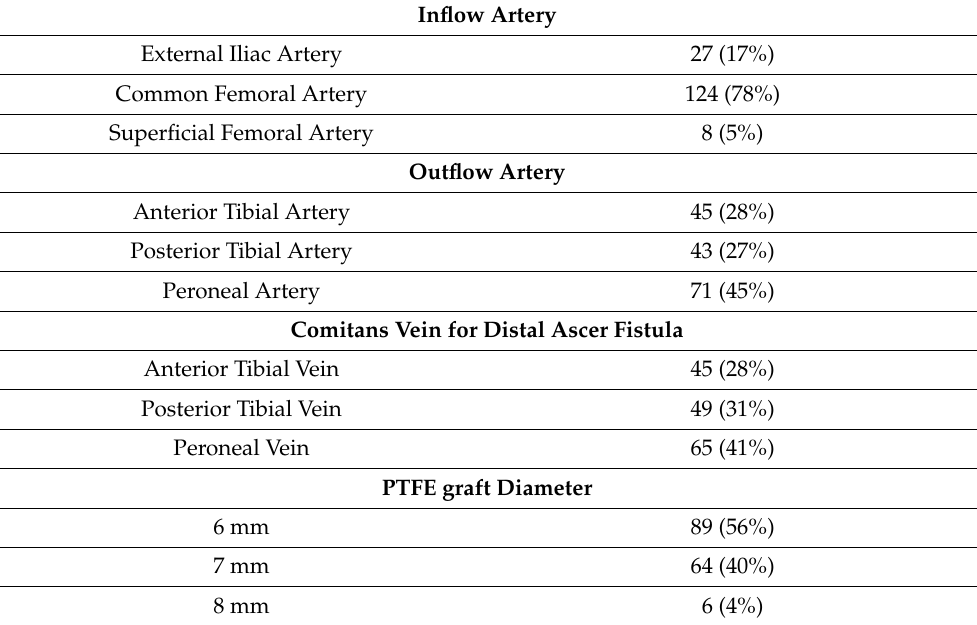
Table 2. Technical bypass